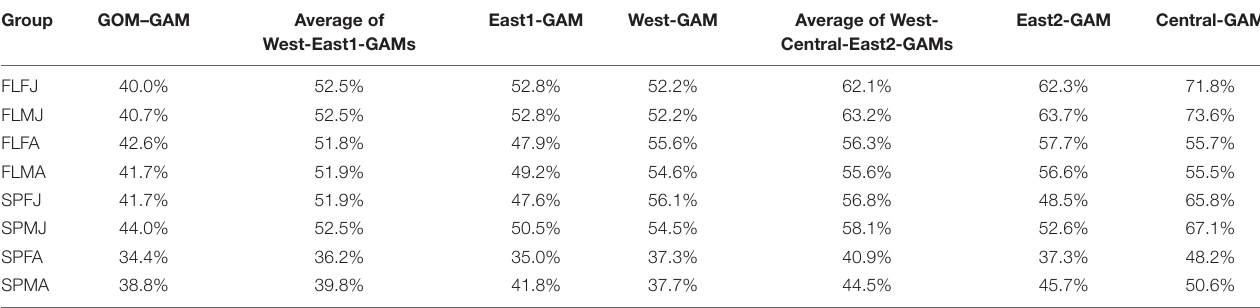
TABLE 2 | Deviance explained for each model and group